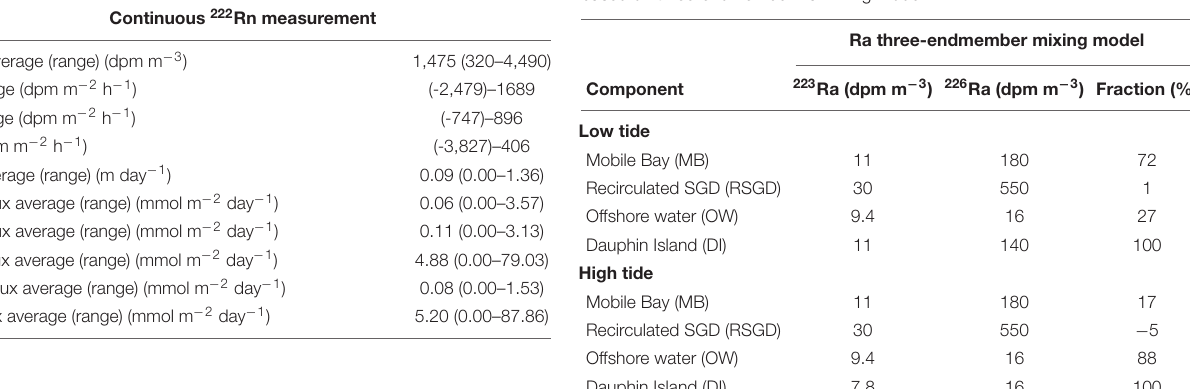
TABLE 3 | Contributions of each endmember to Dauphin Island coastal water based on three-endmember Ra mixing